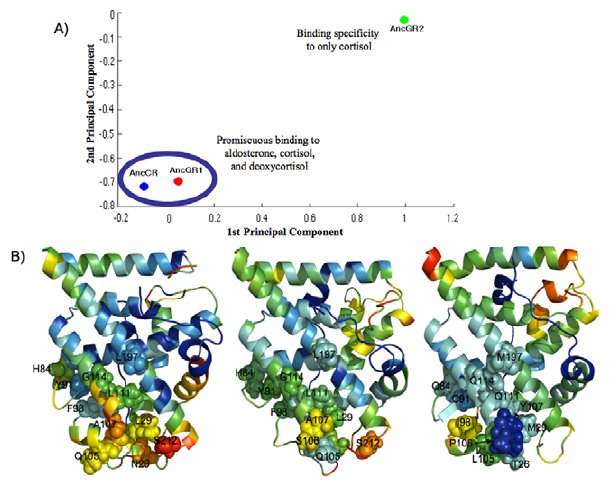
Figure 2. Plot and ribbon diagram of the dynamics of the three ancestral proteins characterized by slowest collective mode. (A) The first two principal components of AncCR, AncGR1 and AncGR2 plotted against each other. The principal components were found via a Singular Value Decomposition of the G matrix (See Methods). Higher order modes are mostly orthogonal or mixed and therefore not represented here. (B) 3D structures of AncCR, AncGR1 and AncGR2 colored by residue fluctuation. The critical mutations in AncCR and AncGR1 have greater flexibility and thus, higher binding promiscuity. AncGR2 has much lower flexibility in general amongst these residues and therefore more selective binding. The S212 D mutation also rigidifies the lower loop at the bottom end of h10 by shortening the loop and removing degrees of freedom. This also alters the packing of h10 (the frontmost helix) and decreases